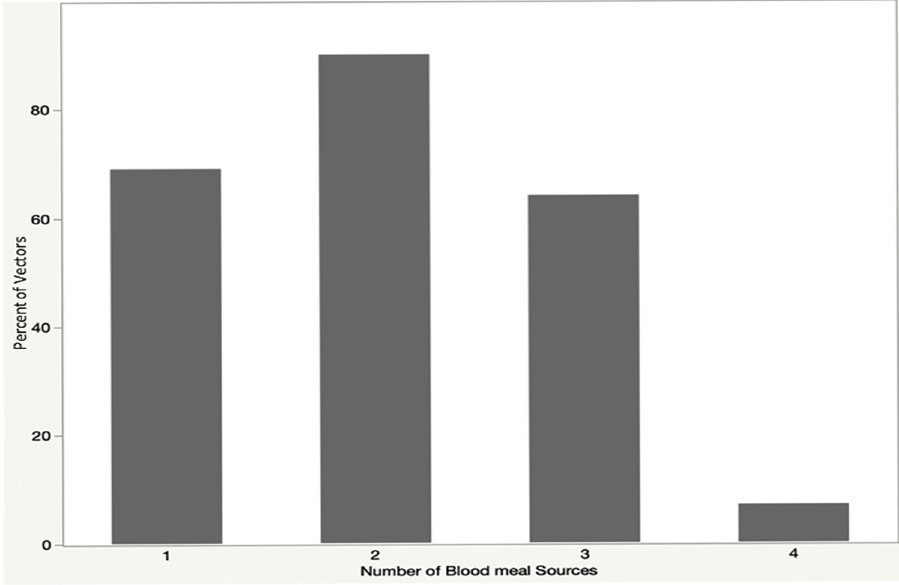
Fig 2. Percentage of bugs with one, two, three and four blood sources identified (N = 232).